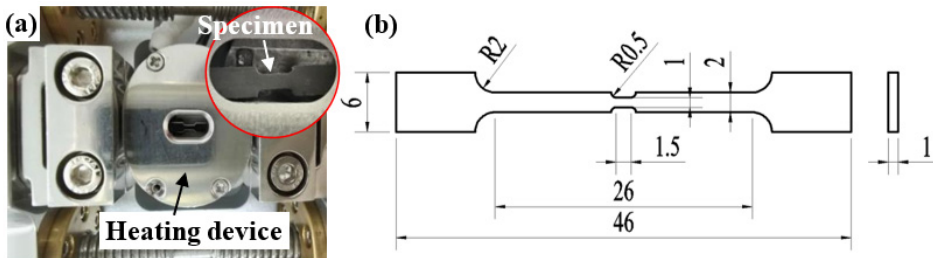
Figure 3. ( a ) Mechanical test bench and heating device; ( b ) Geometry and dimensions of in situ tensile test sample at 350 °C (units: mm).